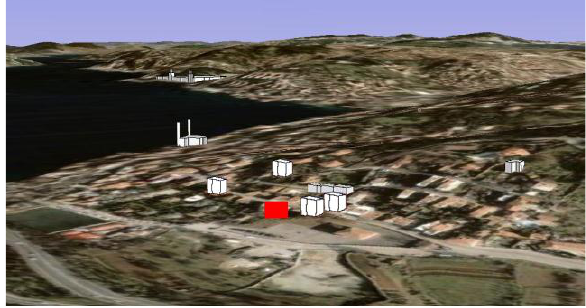
Figure 9. Control Point witch made with Google